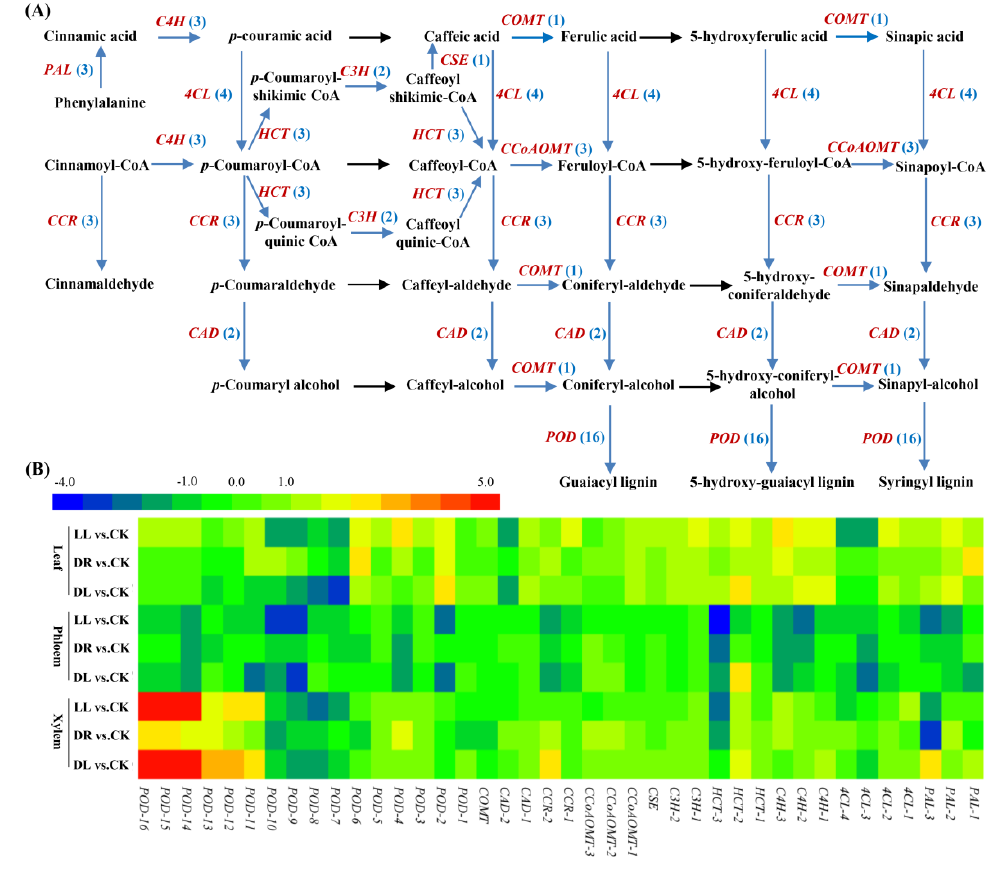
Figure 5. Expression patterns of low light, drought, and their combined stress on DEGs involved in phenylpropanoid biosynthetic pathway: ( A ) the identified DEGs in the phenylpropanoid biosynthetic pathway and ( B ) expression patterns of DEGs in leaves, phloem, and xylem. CK: control; LL: low light; DR: drought; and DL (DR + LL): the combined stress of drought and low light. Detailed information is in Supplementary Table